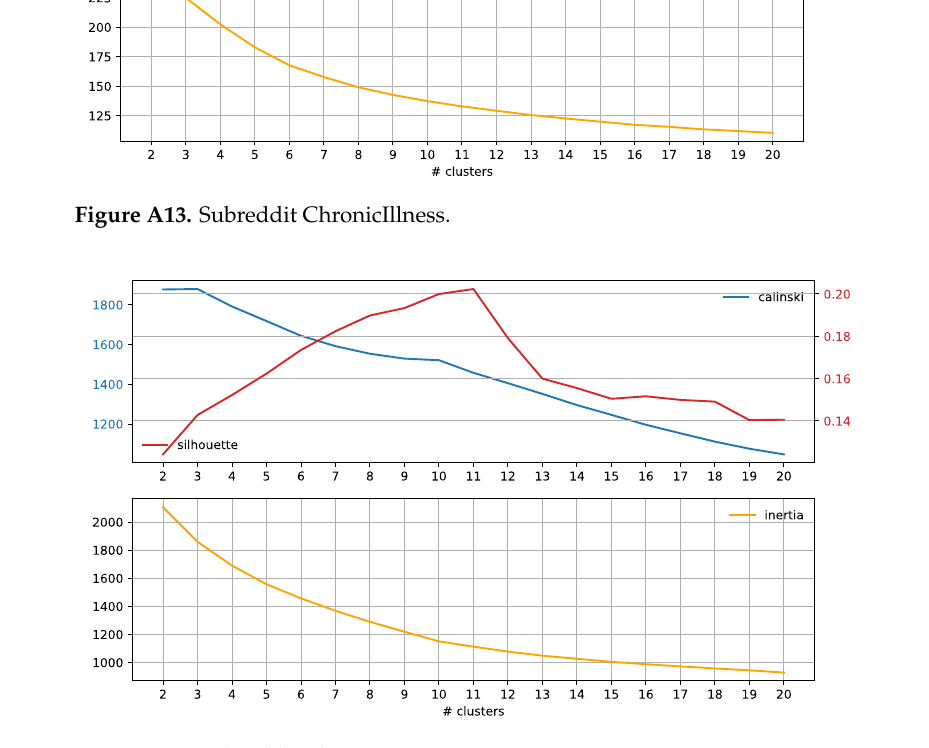
Figure A14. Subreddit ChronicPain.